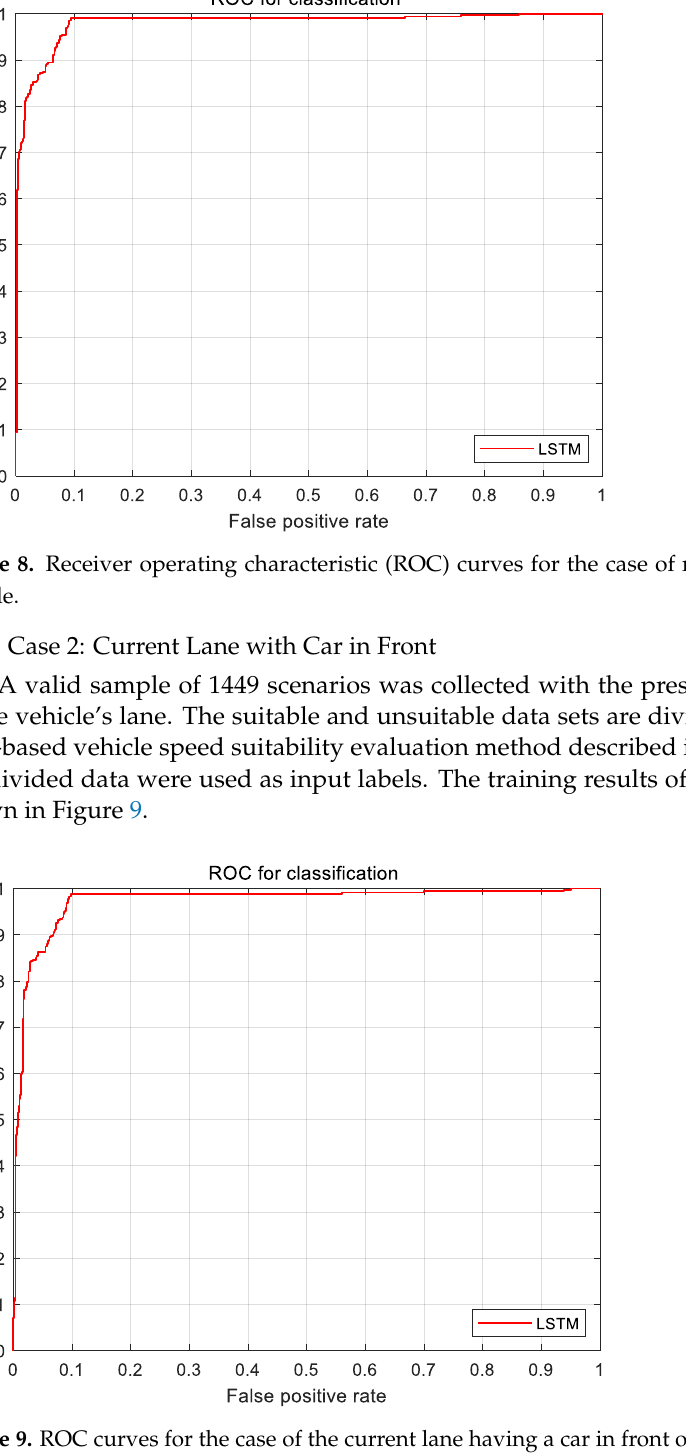
were used for comparison, as shown in Table 3. Table 3. Model recognition accuracy. SVM: support vector machine.